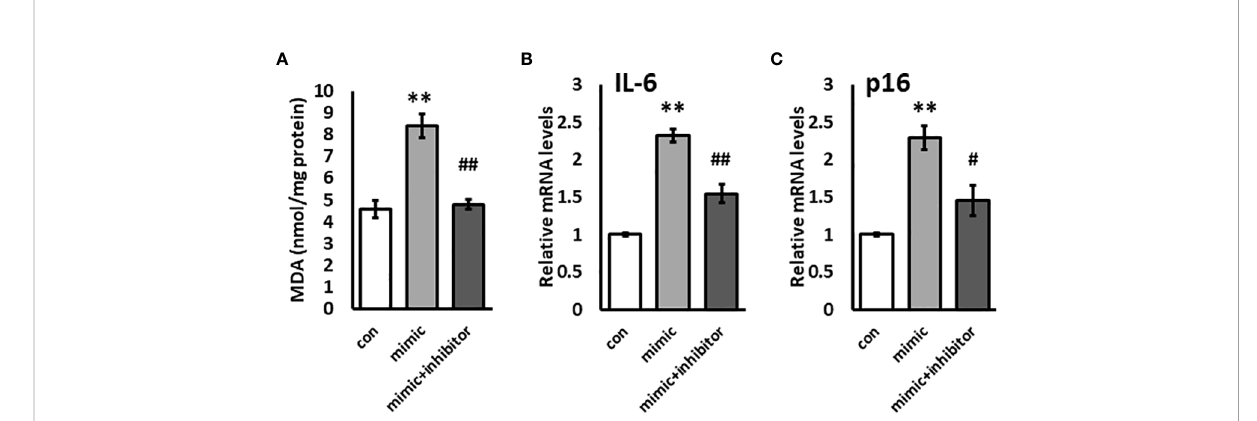
FIGURE 4 Overexpression of miR-192 induces oxidative stress and in fl ammation in HK2 cells. miR-192 mimic, mimic + inhibitor, or scrambled miRNA were transfected into HK2 cells for 72 hours and MDA levels in the cell lysate (A) , and mRNA levels of IL-6 (B) and p16 (C) were